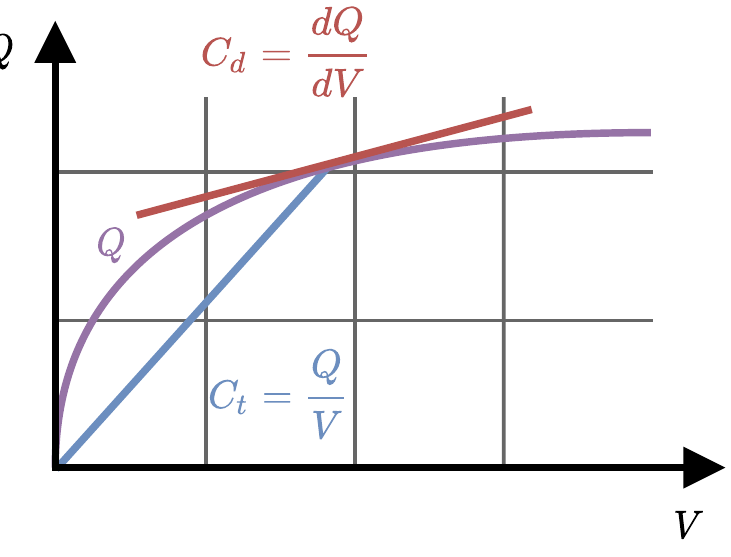
Figure 11. An illustration of the difference between C t and C d